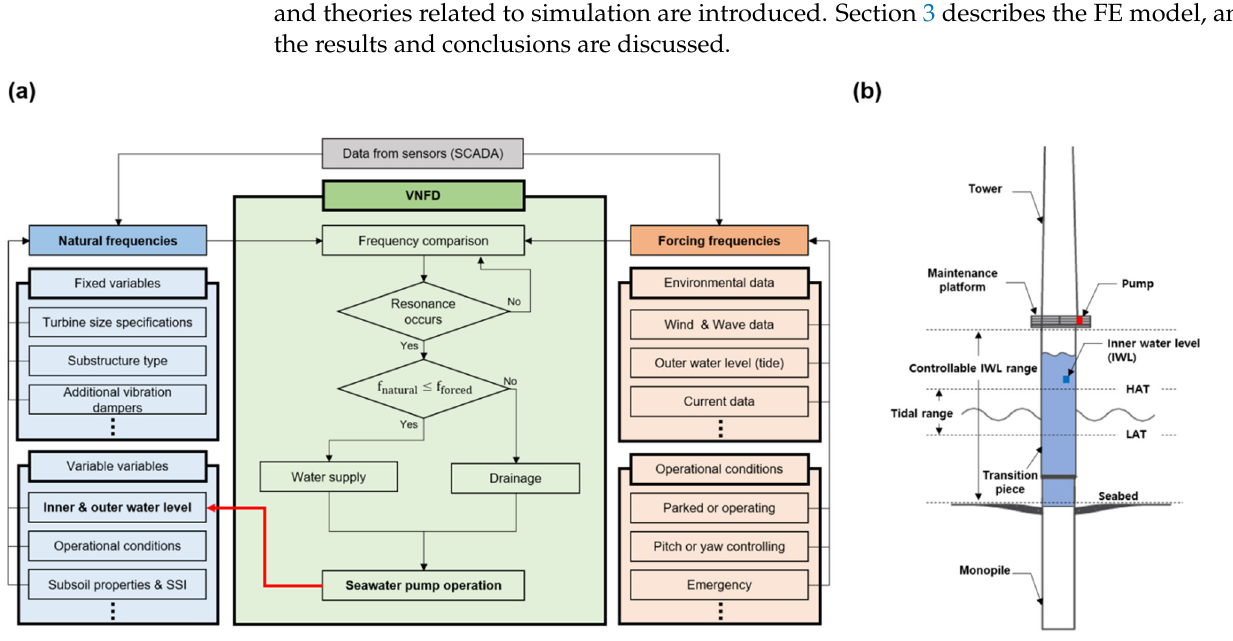
Figure 1. ( a ) System logic of VNFD and ( b ) theoretical configuration.